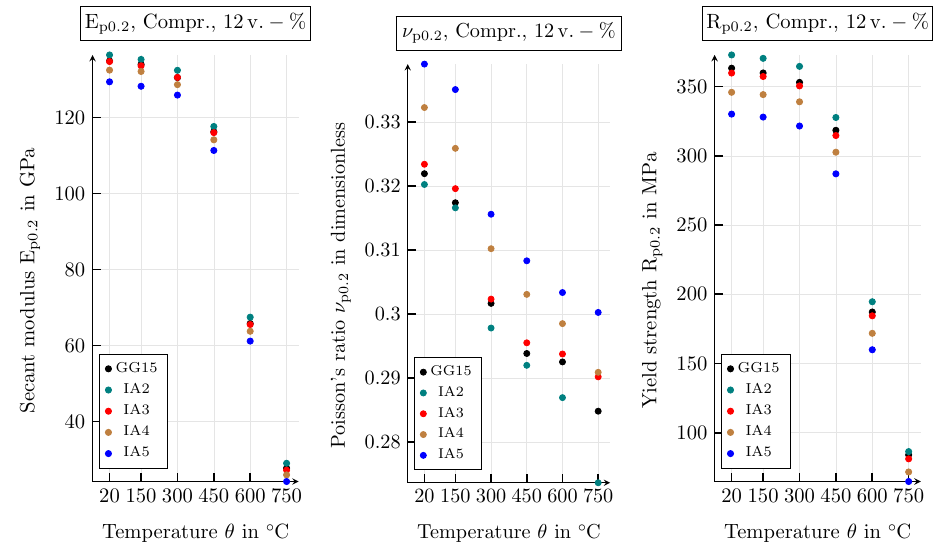
Figure 29. Secant moduli, Poisson’s ratios and yield strengths of all graphite classes with a graphite flake volume fraction of 12v. %, evaluated for the temperatures 20, 150, 300, 450, 600 and 750°C, − at a compressive strain of